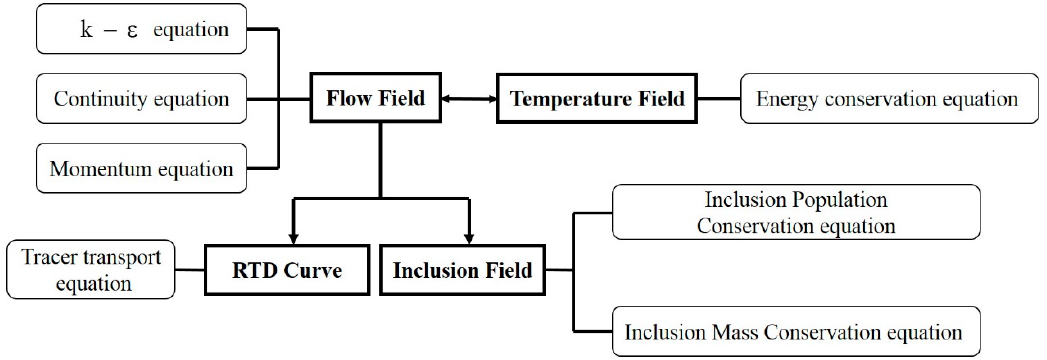
Figure 3. The numerical solution